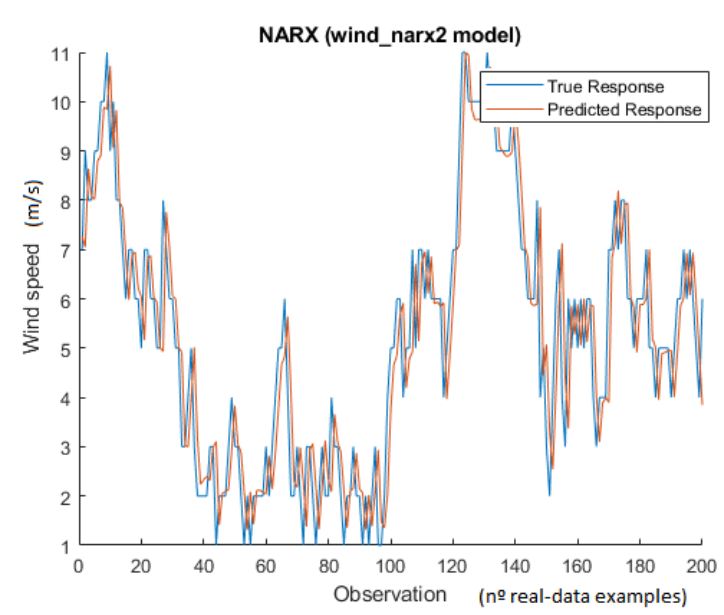
Figure 7. Predicted vs. real output for wind_narx2 model for the first 200 data of 2020.